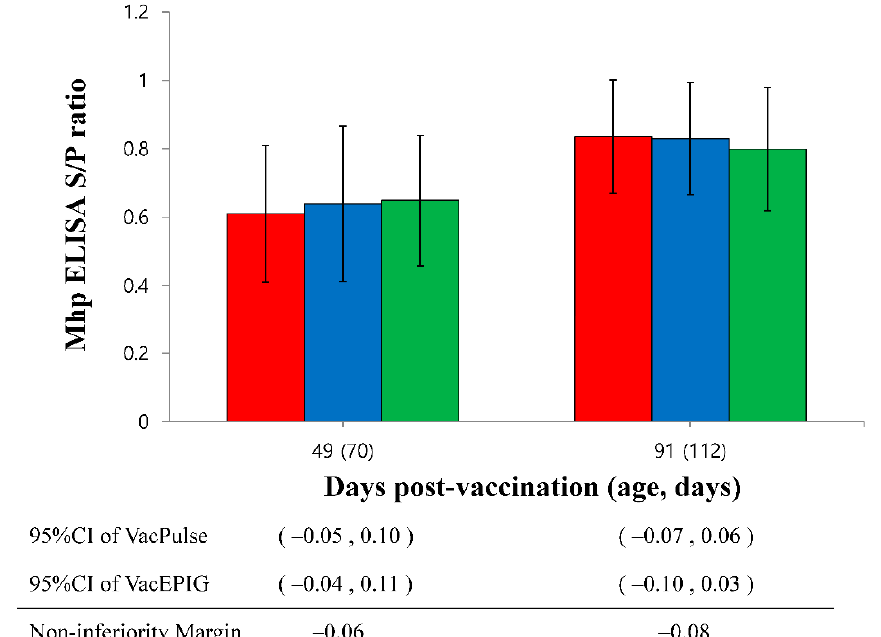
Figure 8. The lower bound of the 95% confidence intervals (CI) on the difference in Mycoplasma hyopneumoniae enzyme ‐ linked immunosorbent assay (ELISA) in the needle ‐ free device (VacPulse, ● ) group at 49 days and 91 days post ‐ vaccination (dpv) showed non ‐ inferiority to conventional needle ‐ syringe (VacS, ● ) group. The lower bound of the 95%CI on the difference in M. hyopneu ‐ moniae ELISA in the needle ‐ free device (VacEPIG, ● ) group at 49 dpv showed non ‐ inferiority to conventional needle ‐ syringe (VacS, ● ) group.